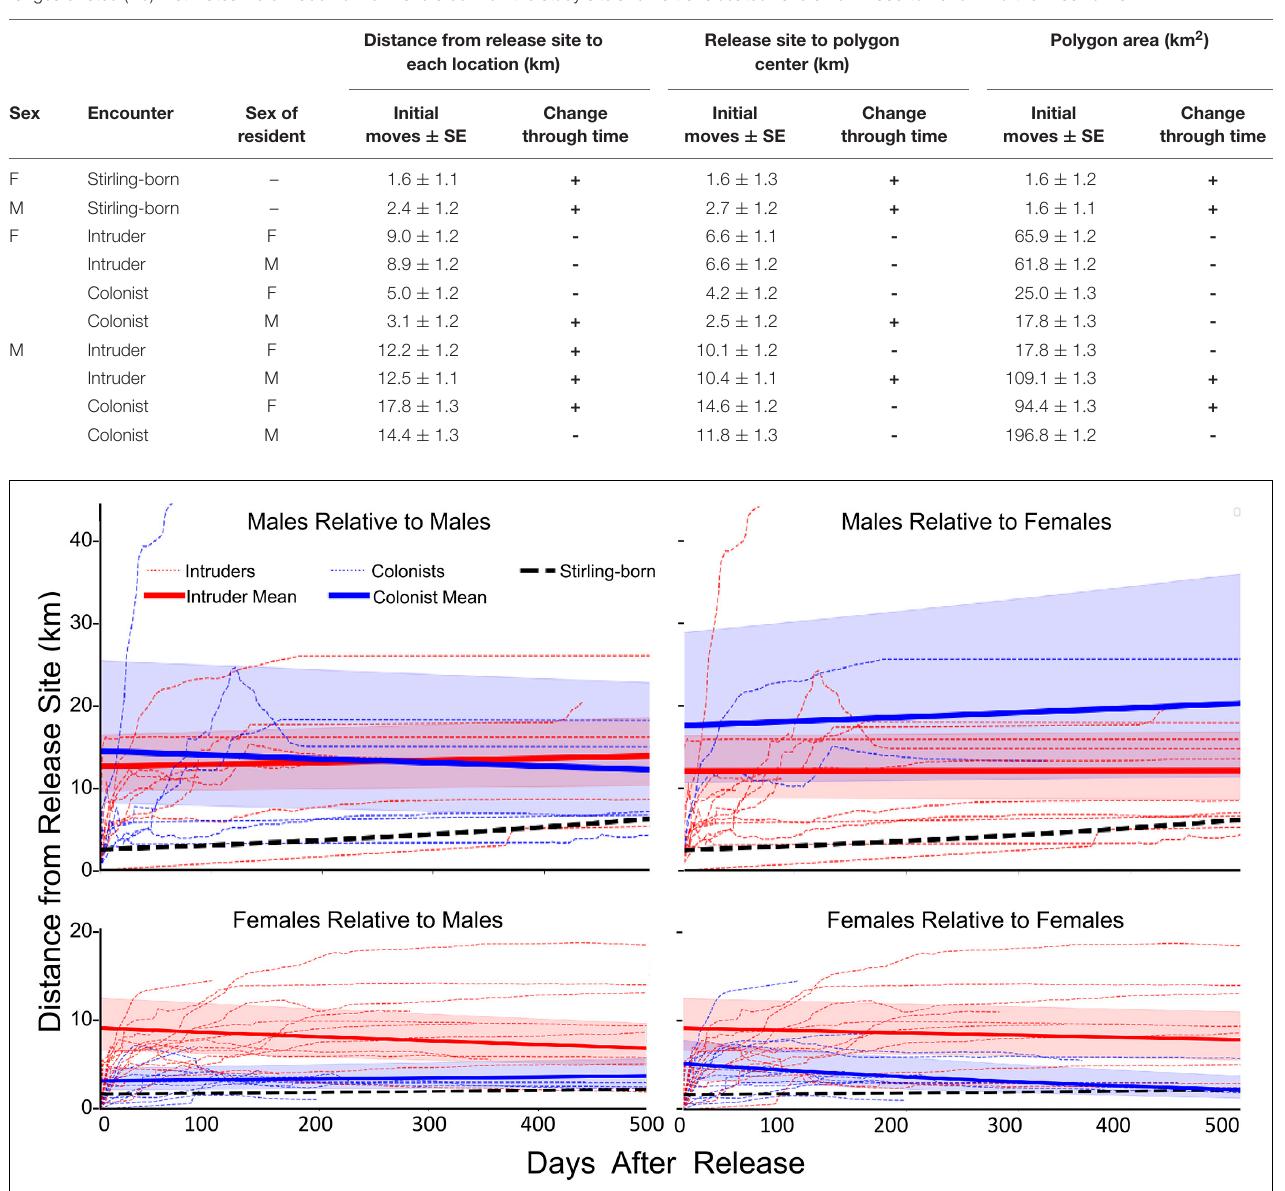
TABLE 2 | Estimates for the first move and slope parameters from generalized linear mixed models for three dependent metrics for female (F) and male (M) fishers that were born on the study site (Stirling-born) and translocated fishers that were released onto the established home ranges of other fishers (Yes) and where no home ranges existed (No). Estimates were made from 57 fishers born on the study site and 40 translocated fishers from 2009 to 2016 in northern California.